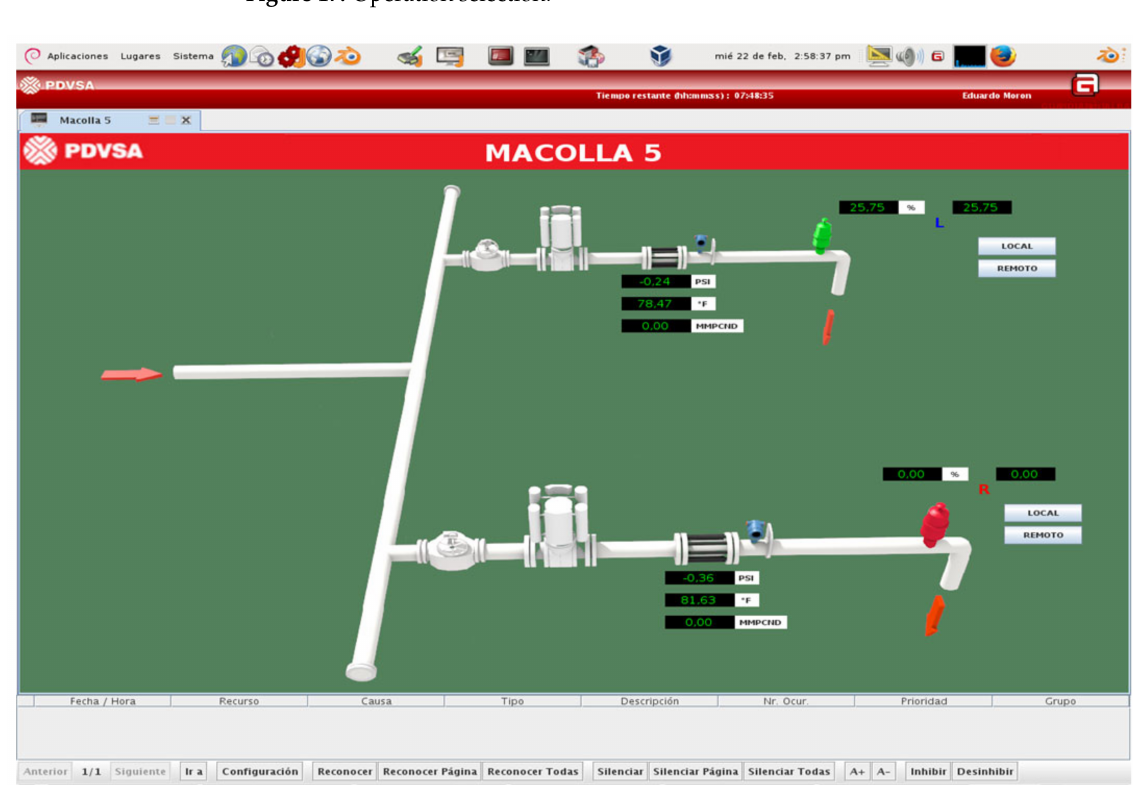
Figure 17. Operation selection.